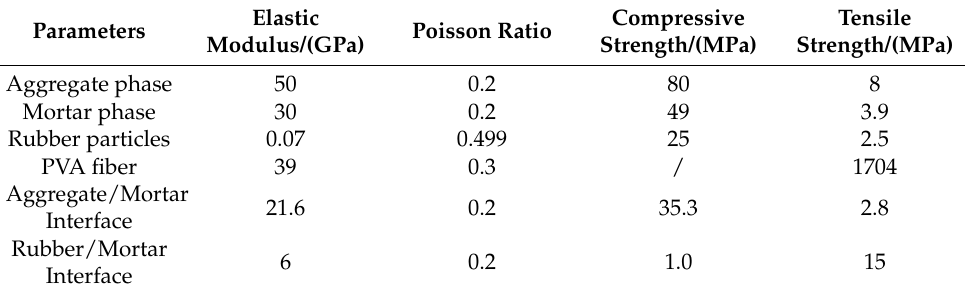
Table 6. Parameters of concrete components used in finite element